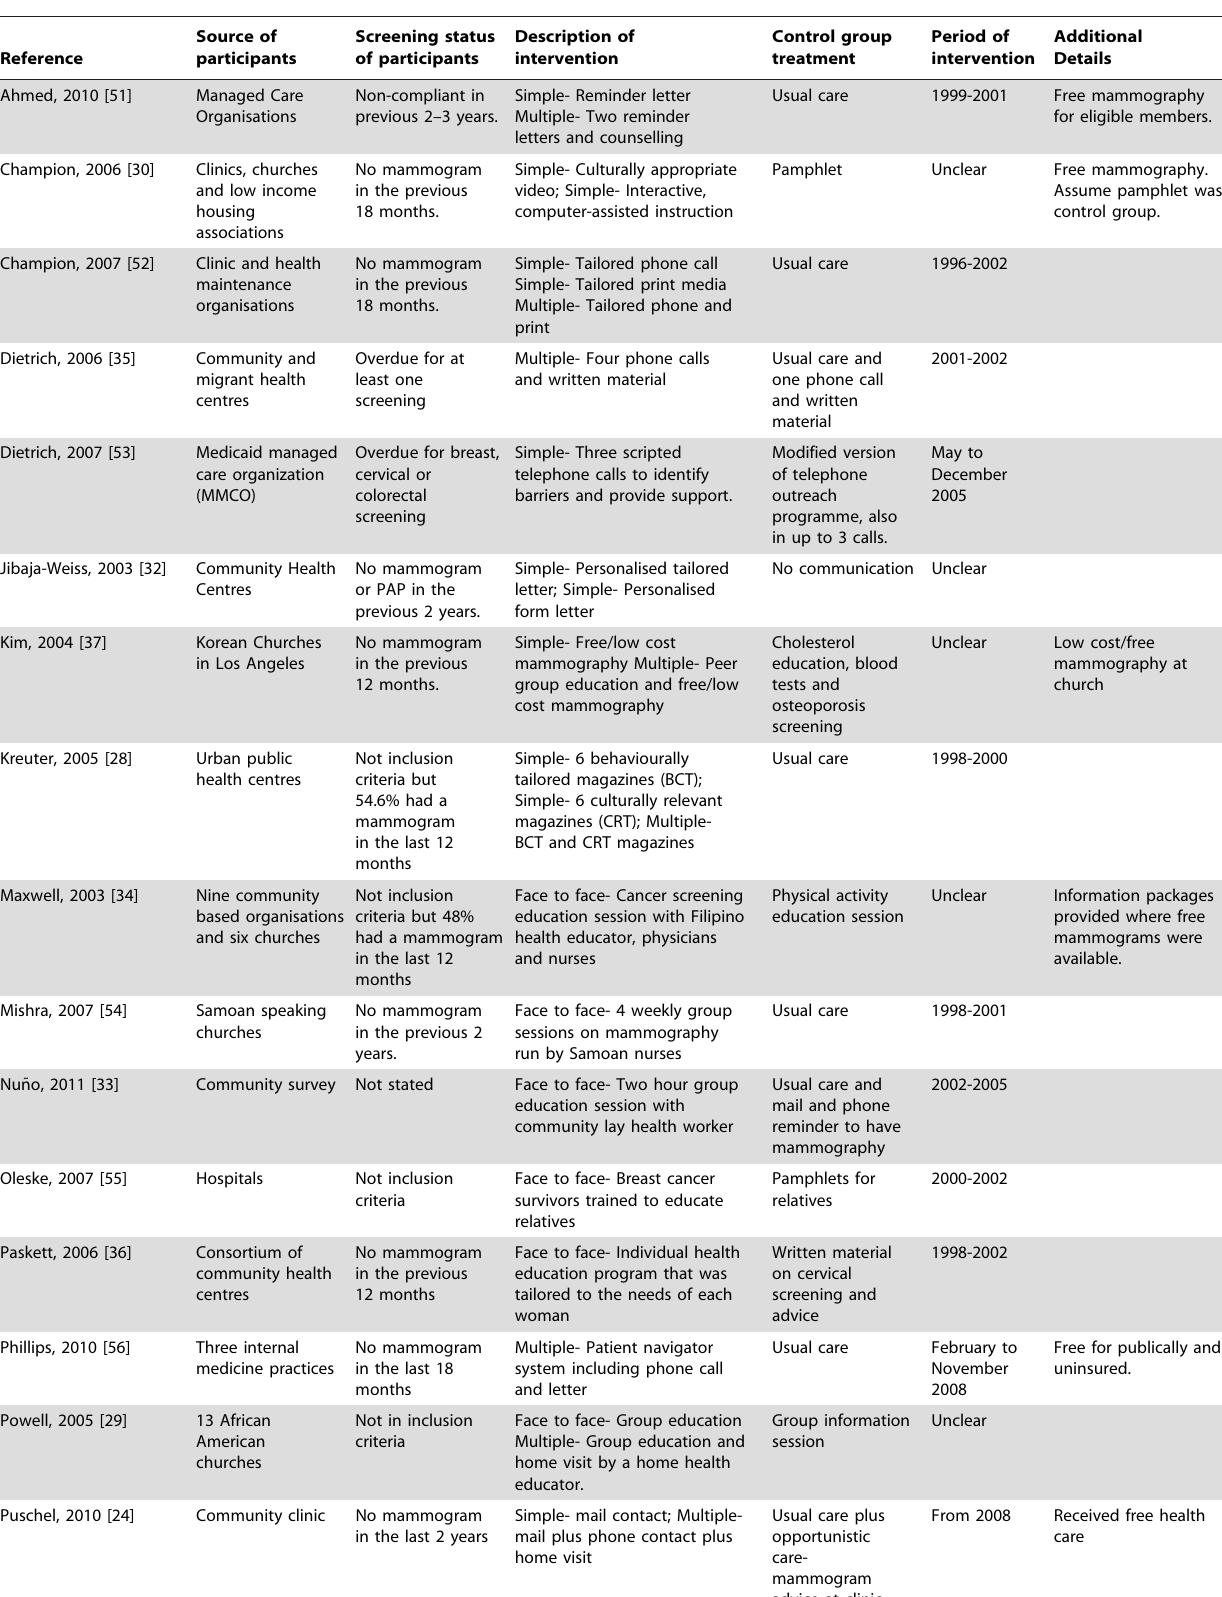
Table 1. Description of studies included in the review.